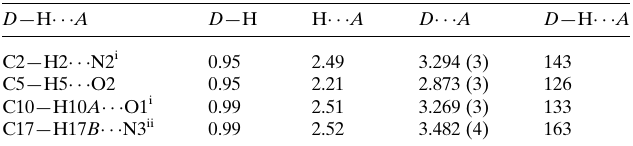
Table 1 Hydrogen-bond geometry (A˚ , (cid:2) ).